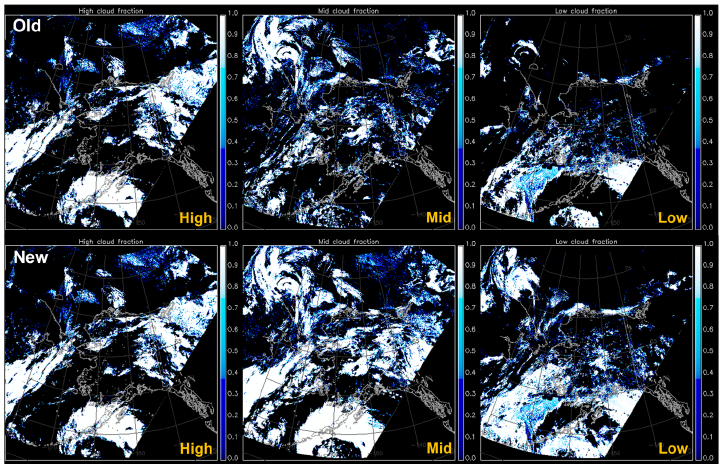
Figure 8. Comparison of cloud fractions from S-NPP VIIRS over Alaska (1355 UTC 29 June 2016) with and without cloud base information, respectively. The top panels show cloud fractions (0–1) only from cloud top heights for each low, middle, and high layer, and the bottom panels show increased middle and low layer cloud fractions by using the new CBH information.